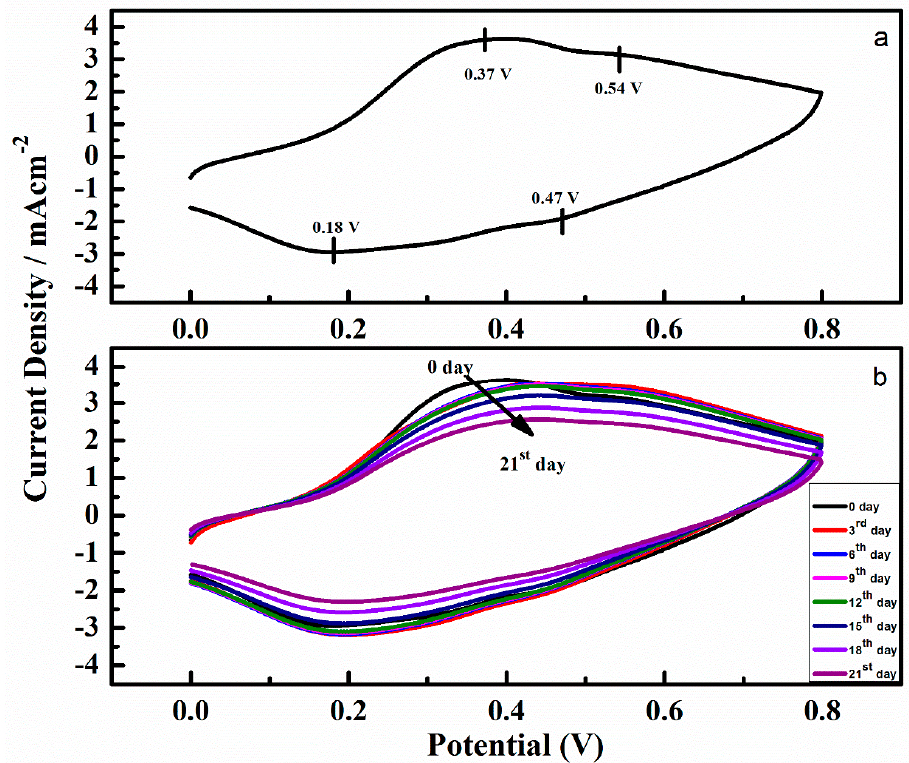
Figure 5. ( a ) Cyclic voltammogram (CV) of patch-5, ( b ) CV curves of patch-5 recorded at the 0th, 3rd, 6th, 9th, 12th, 15th, 18th and 21st day in phosphate buffer.